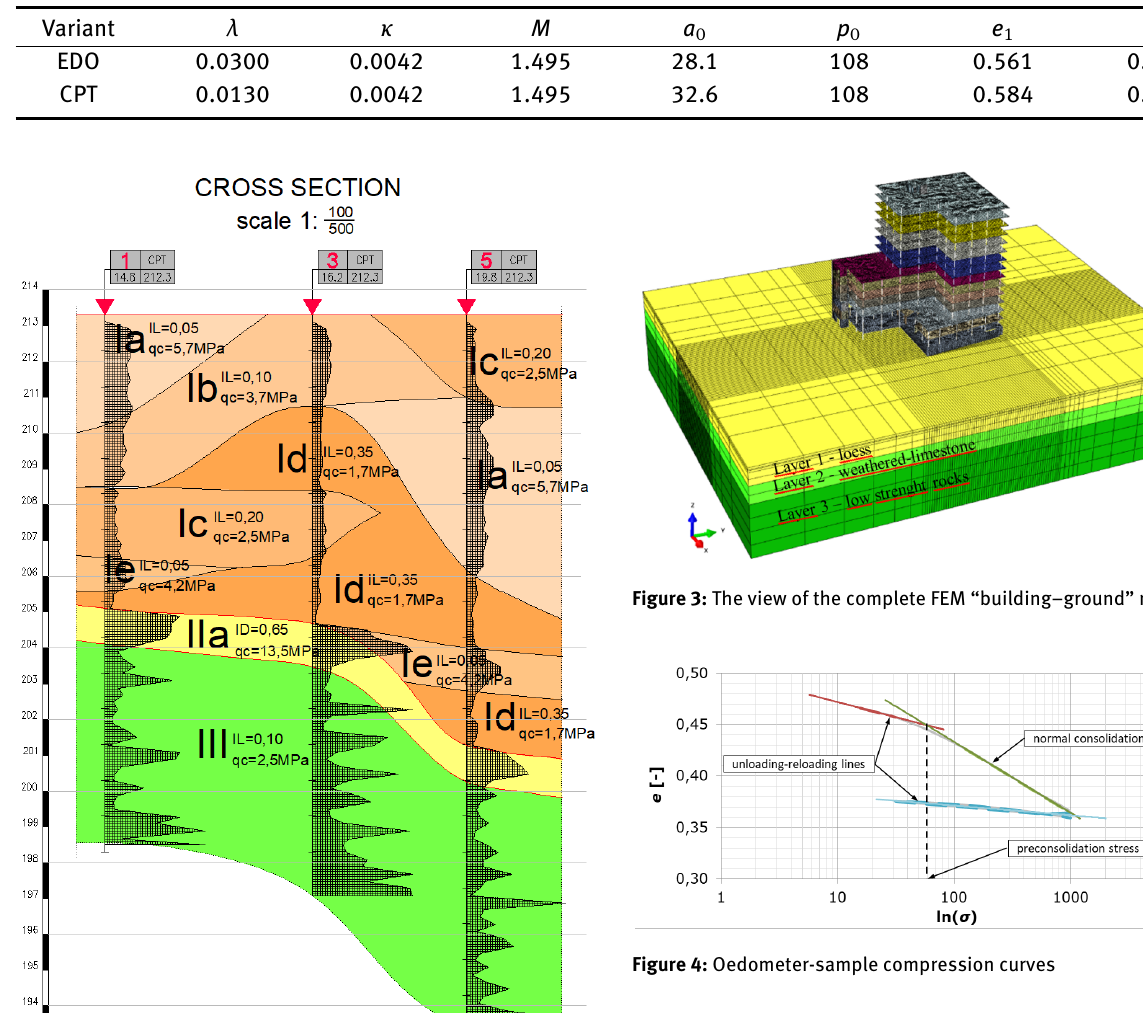
Table 1: The parameters of loess layer for Cam-Clay model